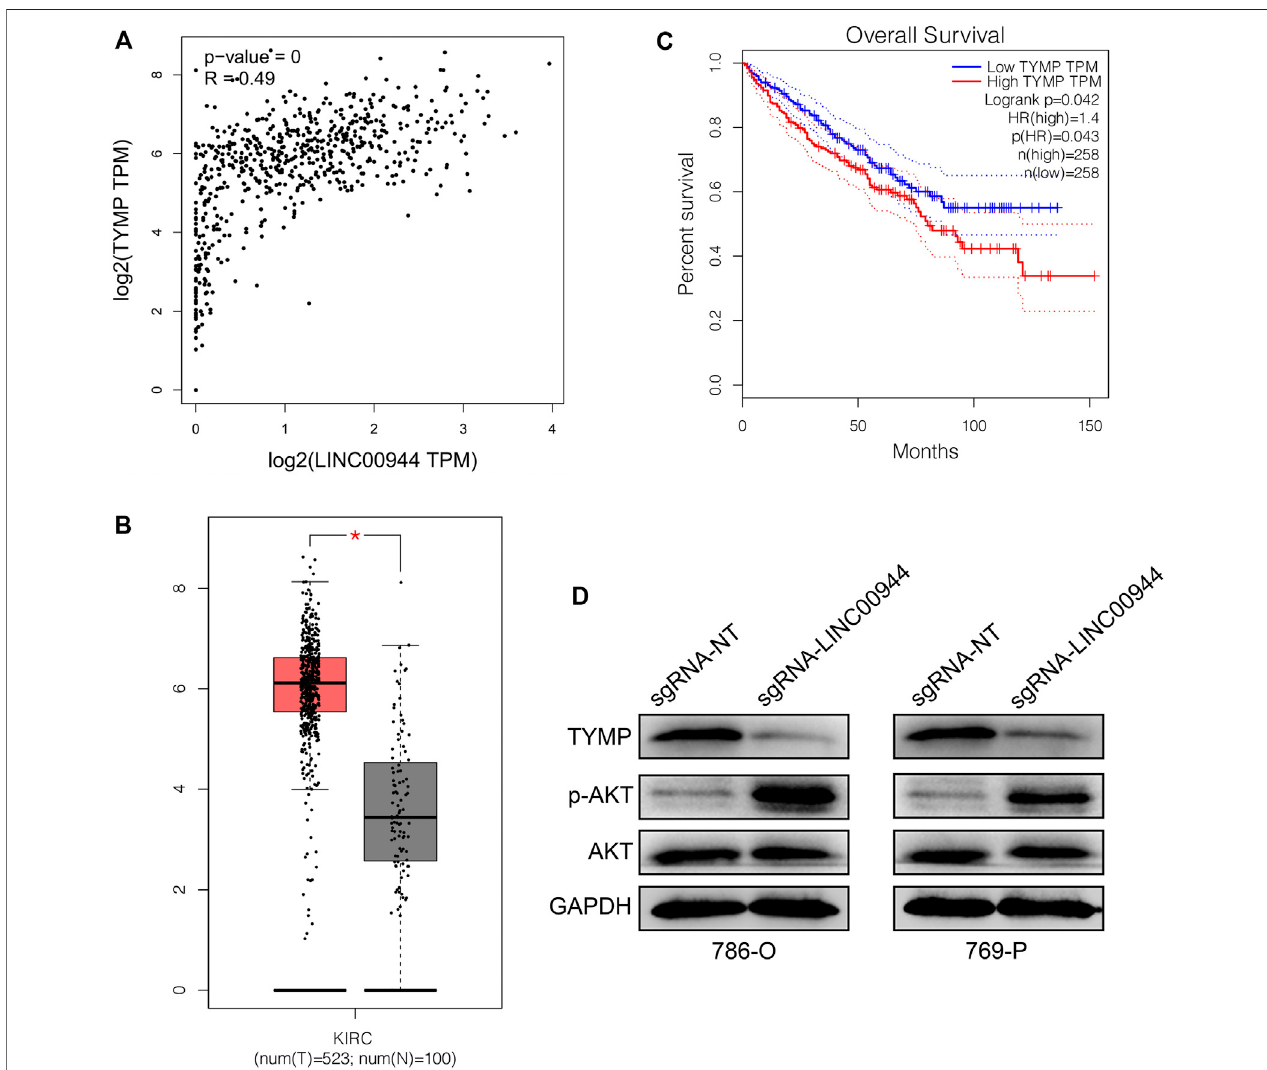
FIGURE 5 | LncRNA LINC00944 regulates TYMP expression and suppresses Akt phosphorylation. (A) LINC00944 expression was signi fi cantly positively correlated with the expression of TYMP in RCC tissues (data from the TCGA database). (B) TYMP expression levels in tumor and adjacent tissues from the TCGA database. (C) Kaplan – Meier survival curves of TYMP in RCC tissues from the TCGA database. (D) Protein levels of TYMP and Akt phosphorylation in 786-O and 769-P RCC cells transfected with dCas9-KRAB and sgRNAs. * p <